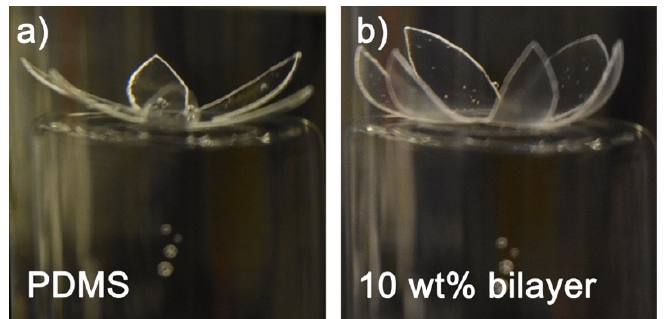
Figure 3. ( a ) Polydimethylsiloxane (PDMS) without polyacrylamide (PAAm) layer. ( b ) Bilayer samples with 10 wt% initial monomer concentration. All samples in DI water. The flower shape is designed to unfold after implantation in the eye. This structure shown would cover 34 mm on the retina, equivalent to a visual field of about 113° [46].